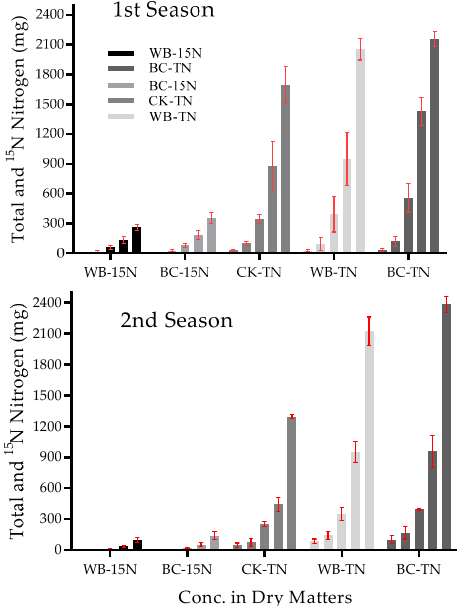
Figure 3. In each season, five dry matter samples were prepared, and accumulative values with error bars [standard mean of error (SEM)] presented for the BC-15N and the WB-15N ( 15 N in biochar and without biochar treatments), CK-TN, WB-TN, and BC-TN (total nitrogen in control, biochar, and without biochar treatments). BC accumulative total and trace nitrogen consumption was more than other treatments. 15 N uptake was not different in BC and WB up to the third dry matter (50 days after fertilization) but thereafter exceeded in BC and lasted up to the end of the second cropping season.